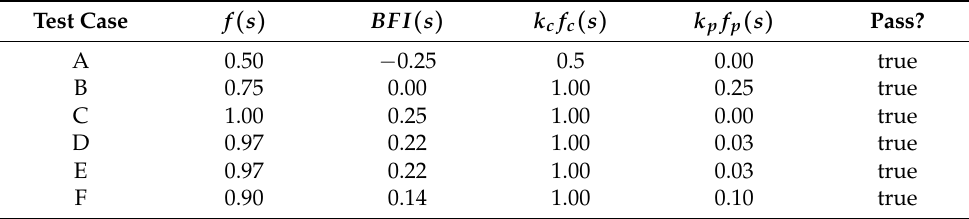
Table 5. Robustness results for k c = 1.0, k p =